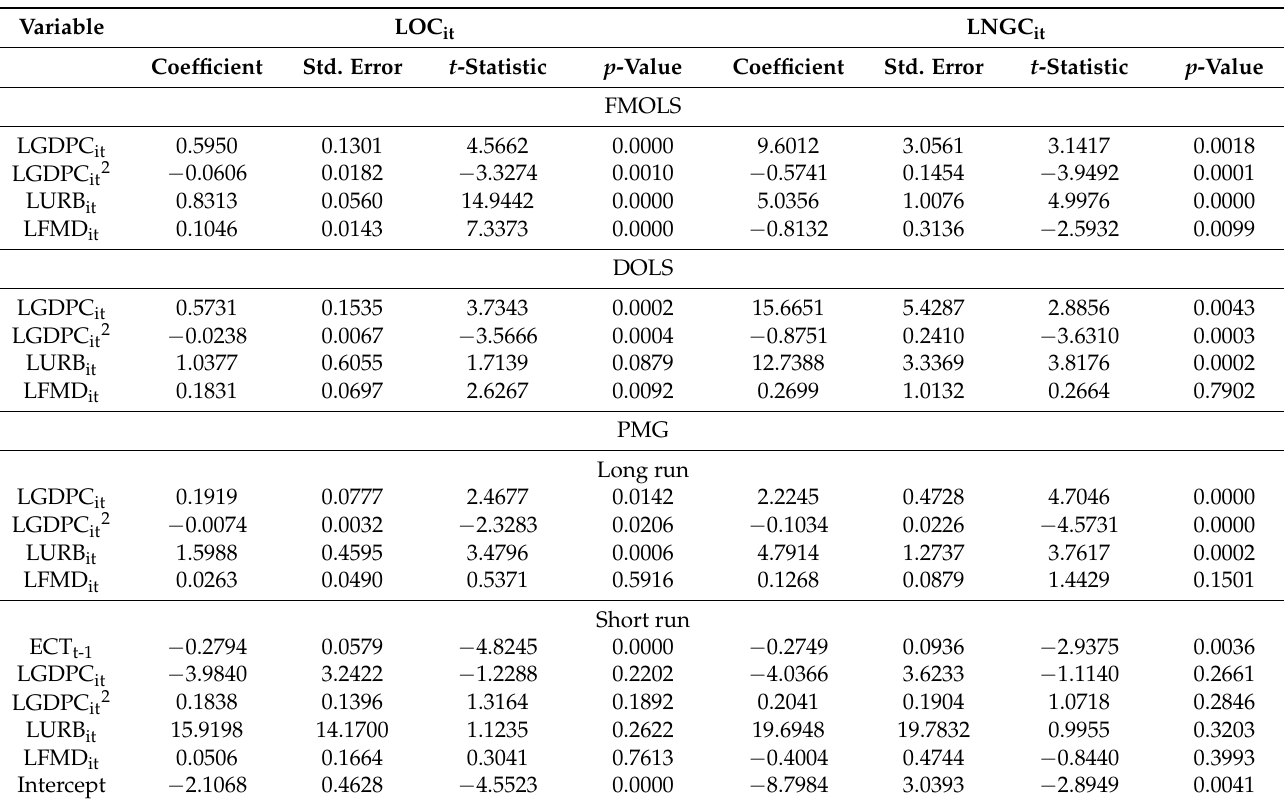
Table A4. Long- and short-run results.